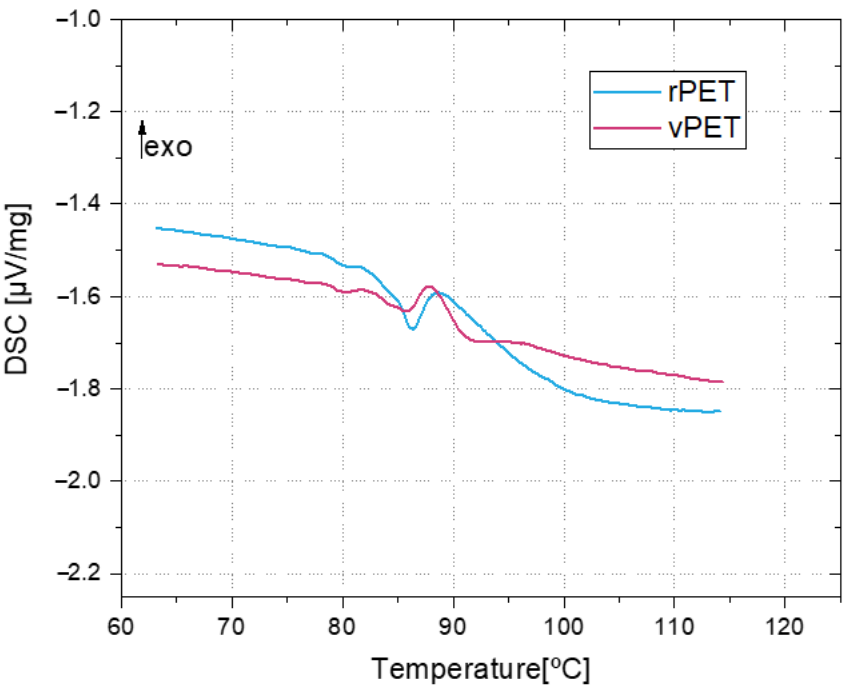
Figure 13. Second heating cycle of the DSC measurement at 20